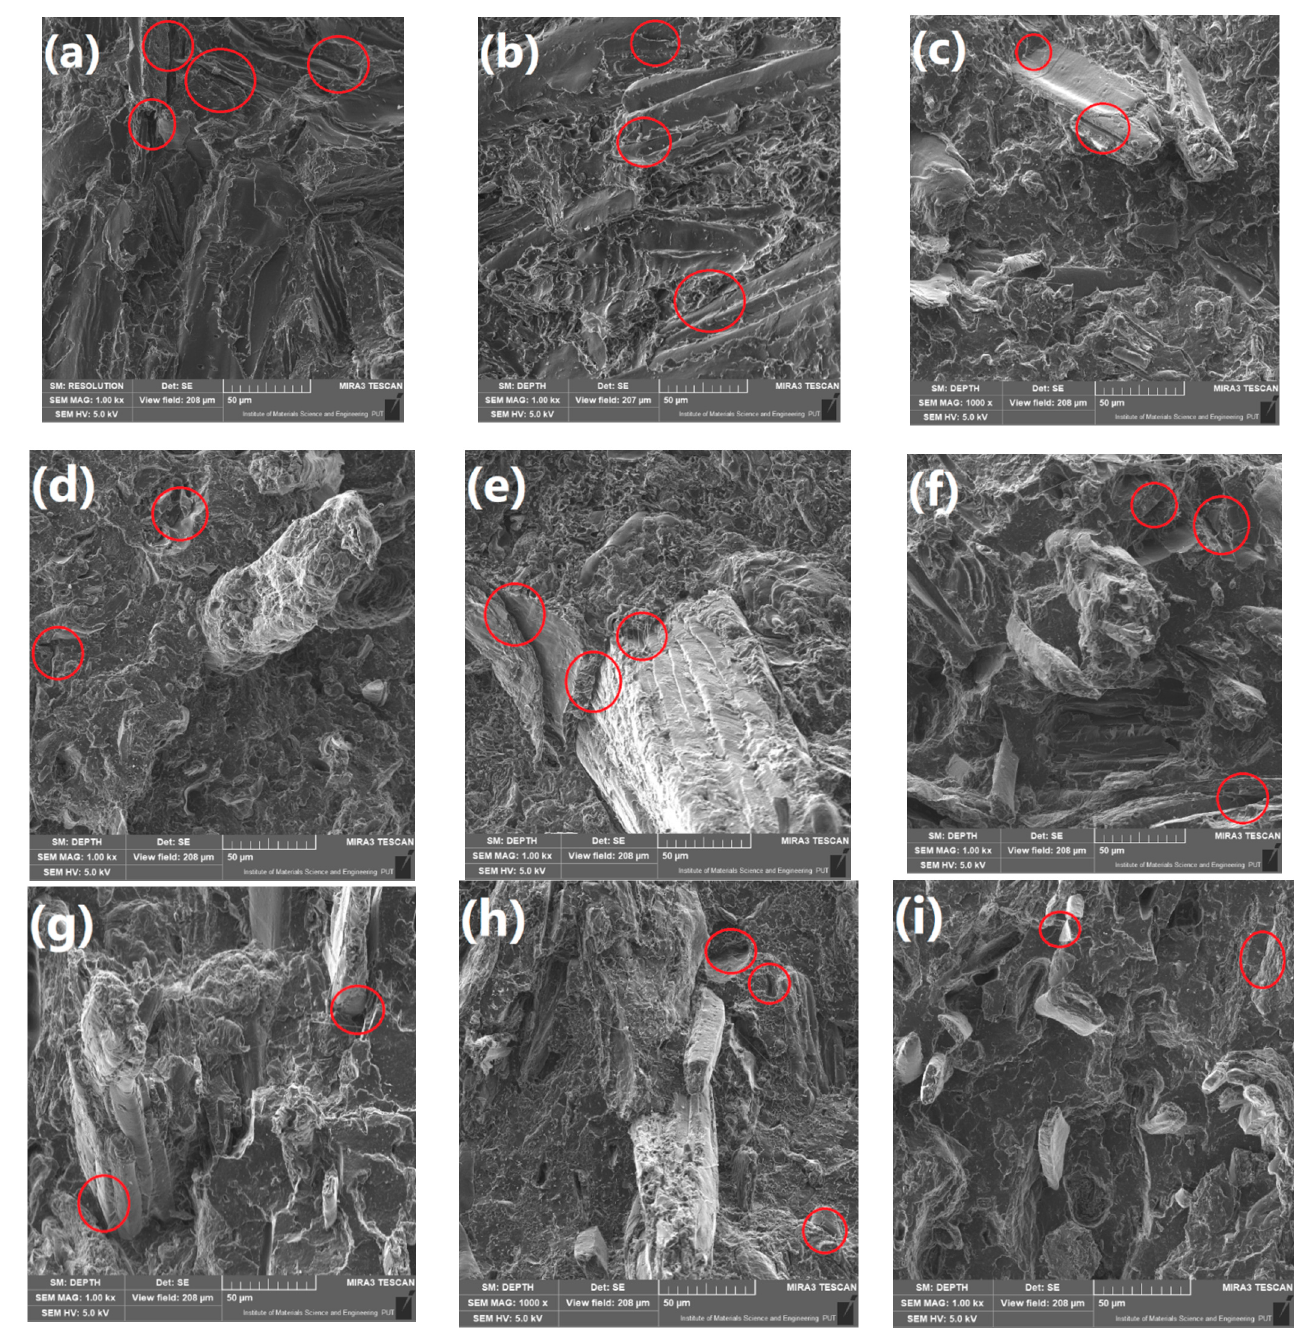
Figure 4. SEM images of brittle fracture areas of samples ( a ) WF 100 , ( b ) WF 75 BSG 25 , ( c ) WF 50 BSG 50 , ( d ) WF 25 BSG 75 , ( e ) WF 0 BSG 100 , ( f ) WF 75 ŁK 25 , ( g ) WF 50 ŁK 50 , ( h ) WF 25 ŁK 25 , and ( i ) WF 0 ŁK 100 under magnification of ×